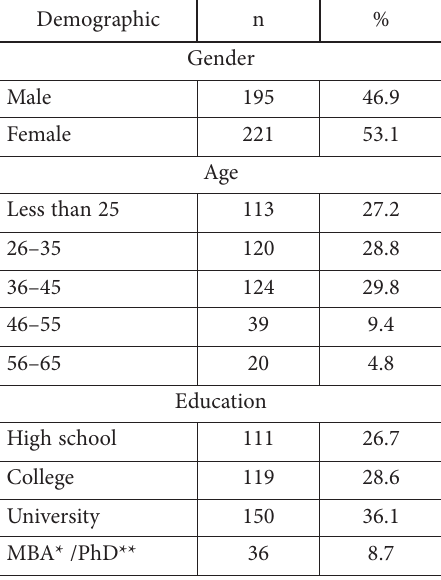
Table 1. Demographic profile of respondents (N = 416) (source: created by authors) Demographic